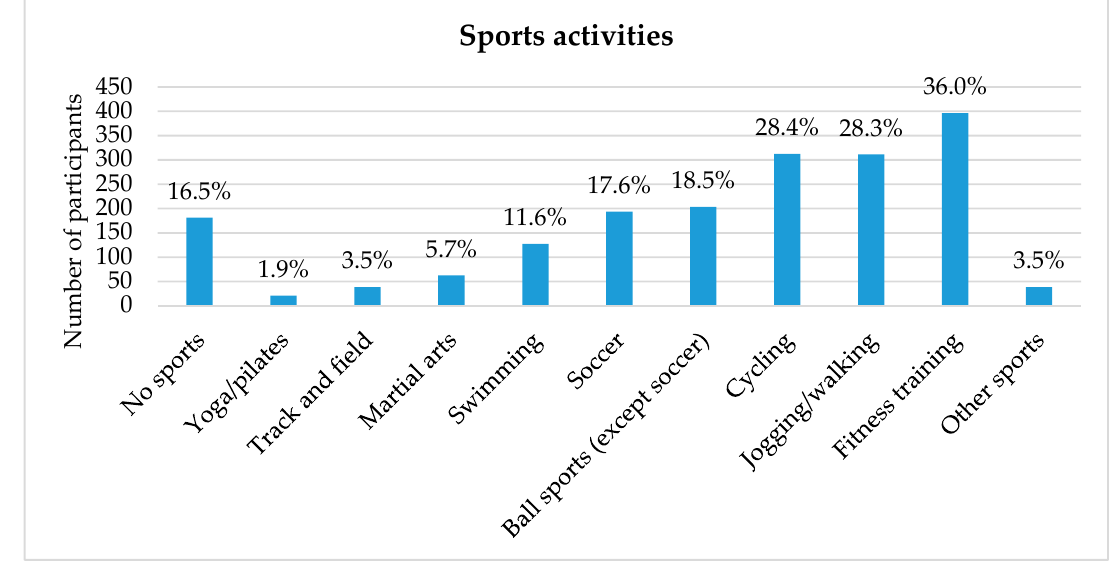
Table 2). Int. J. Environ. Res. Public Health 2020 , 17 , x